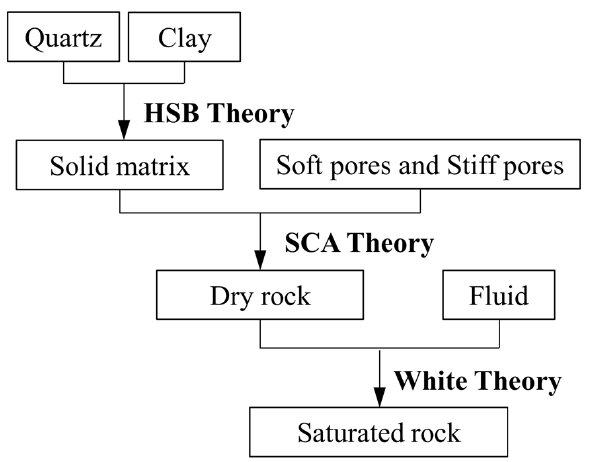
Figure 2. Rock physics modeling workflow for tight sandstones.